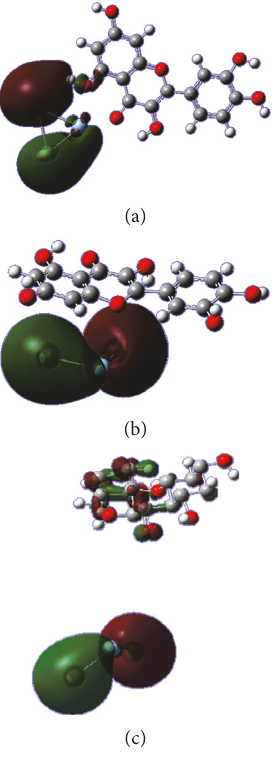
Figure 15: HOMO surfaces from molecular dynamics. Quercetin with 3-atom silver clusters at (a) 0ps, (b) 5ps, and (c) 20ps.